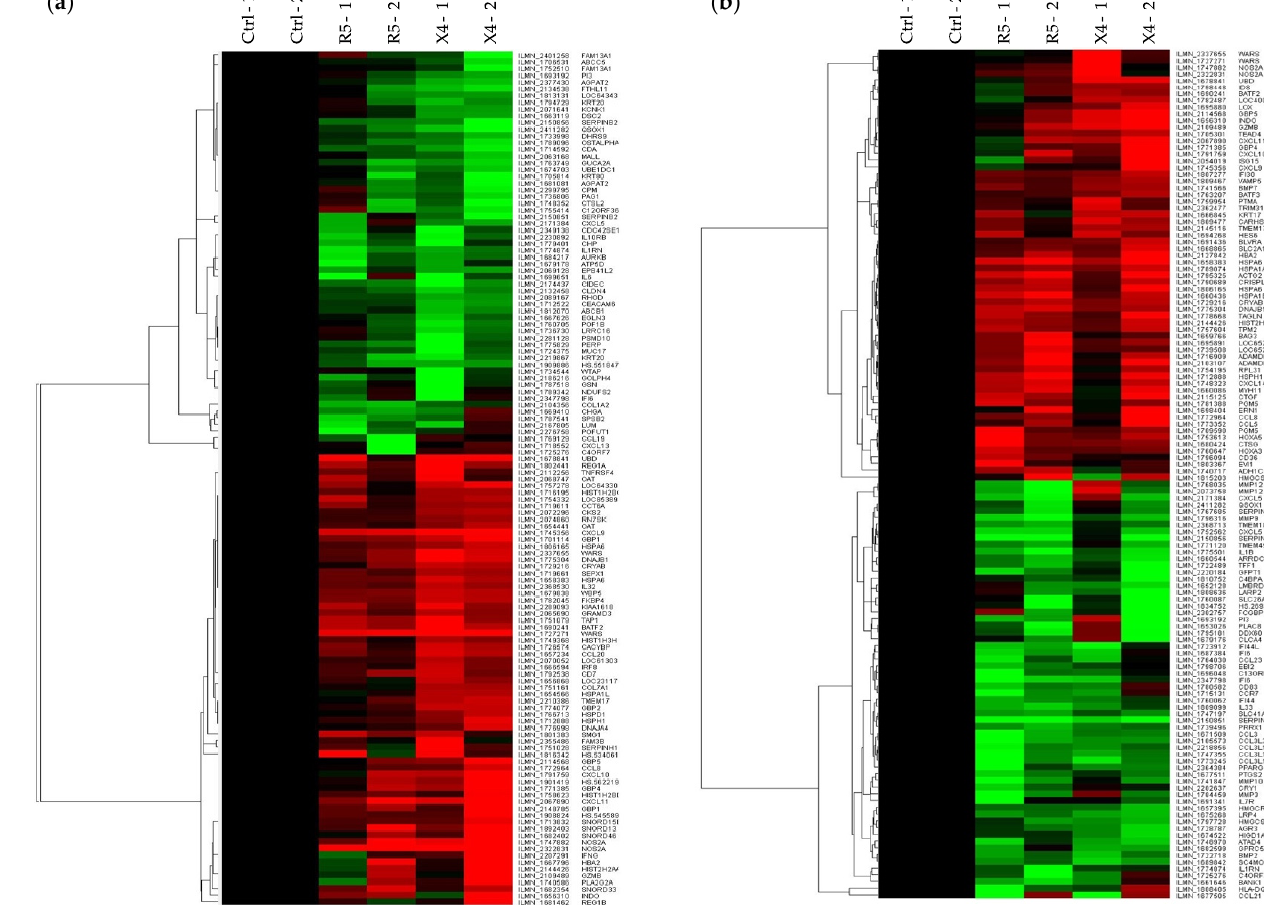
( d ) Figure 4. Cont